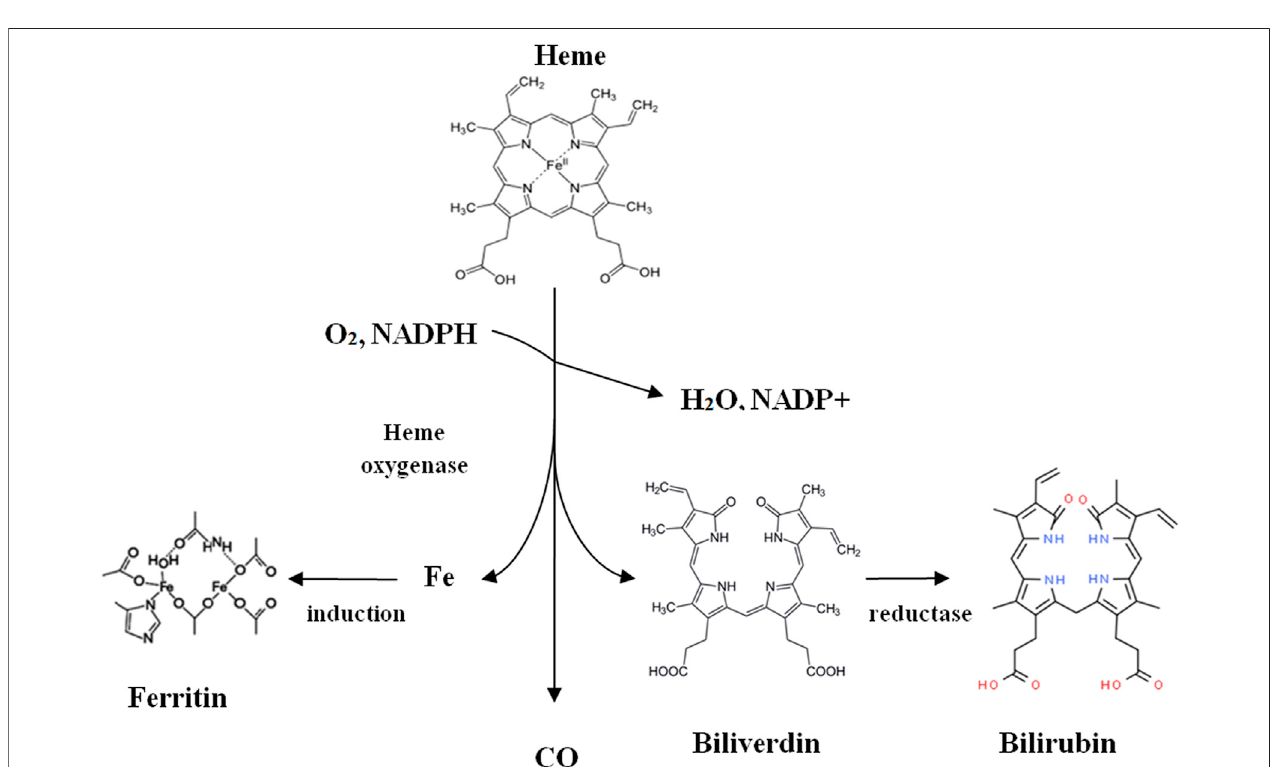
FIGURE 4 | Heme catabolism (Adach et al.,